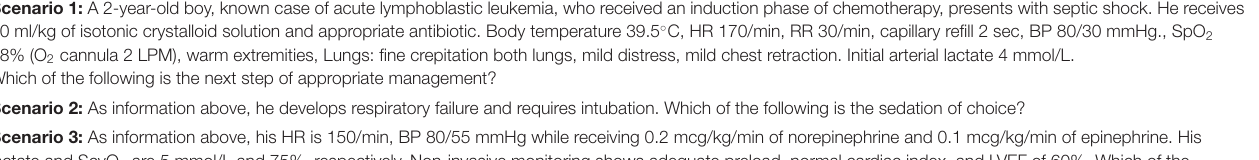
TABLE 1 | Description of the six scenarios of pediatric septic shock. Scenario 1: A 2-year-old boy, known case of acute lymphoblastic leukemia, who received an induction phase of chemotherapy, presents with septic shock. He receives 40 ml/kg of isotonic crystalloid solution and appropriate antibiotic. Body temperature 39.5 ◦ C, HR 170/min, RR 30/min, capillary refill 2 sec, BP 80/30 mmHg., SpO 2